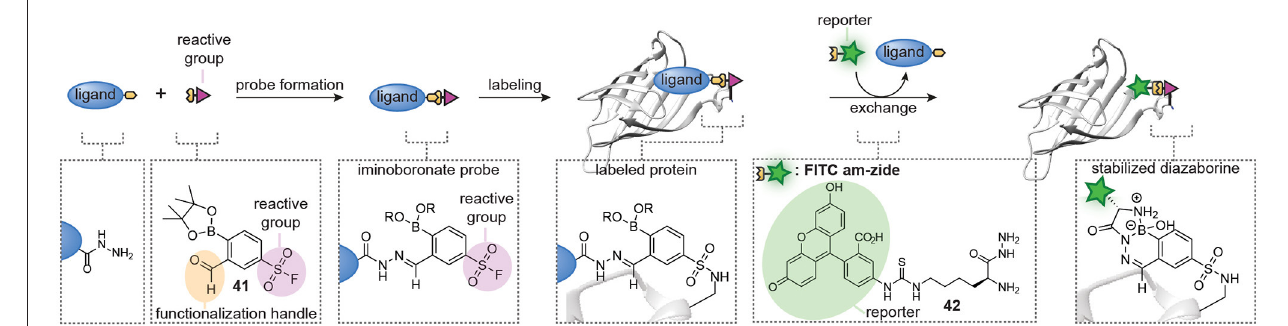
FIGURE 10 | Schematic representation of in situ probe formation with iminoboronate chemistry. A hydrazide ligand is reacted with a 2-FPBA-functionalized reactive group, for example a sulfonyl fluoride ( 41 ), to form an iminoboronate probe. The resulting probe is used without further purification. Probe labeling is visualized via a